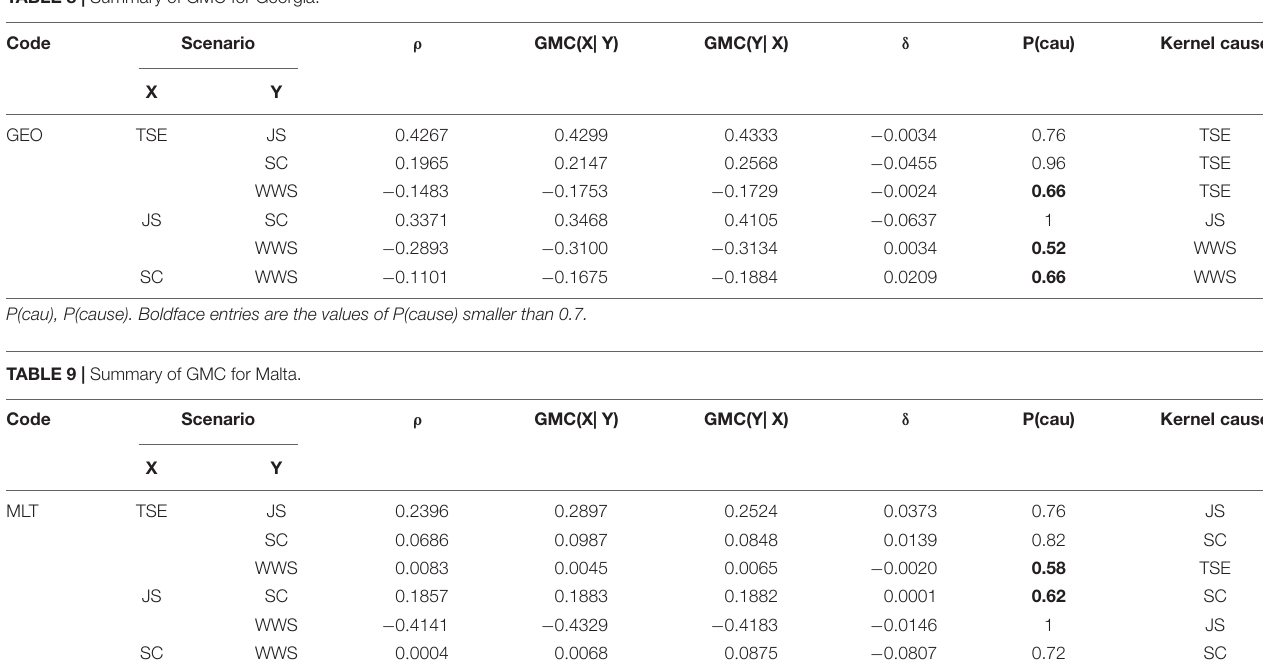
TABLE 8 | Summary of GMC for Georgia.